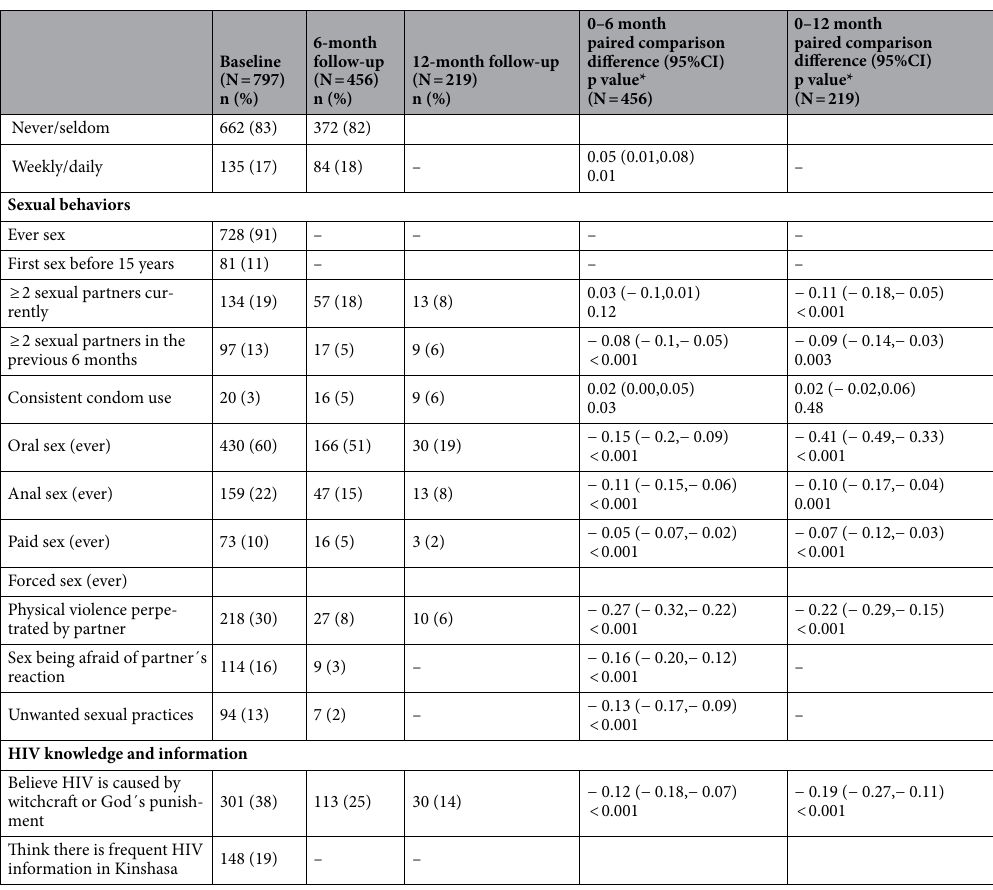
Table 1. Sociodemographics, health, sexual behaviors and HIV knowledge of OKAPI participants at baseline and 6- and 12-month follow-ups and paired changes between baseline and follow-up. ‘–’: variables not included in 6- or 12-month questionnaires. a VCT Voluntary Counseling and Testing. b ARV antiretroviral. *McNemar test p